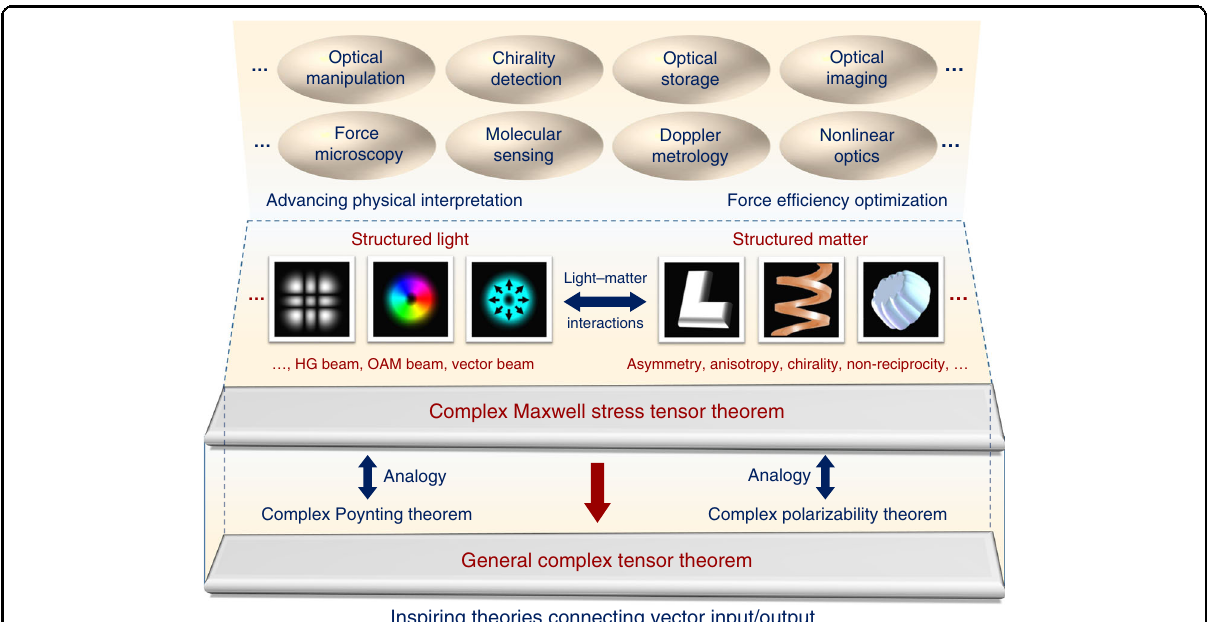
Fig. 2 Future vision of the CMST theory for fundamental physics and advanced